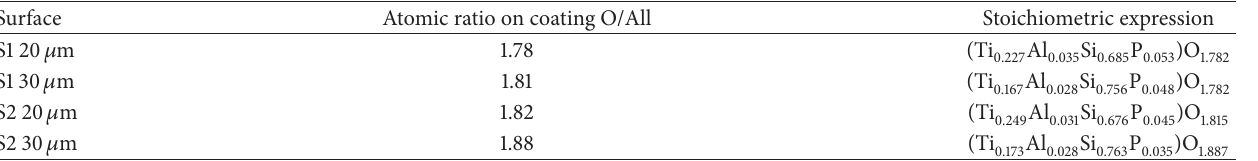
Table 4: The atomic ratio of oxygen versus cations on the polished coating surfaces.